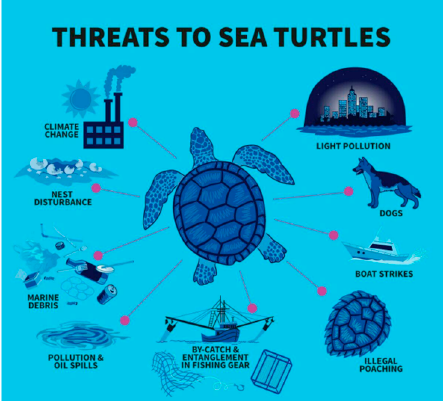
Figure 1. Main threats for sea turtles. Source [34].